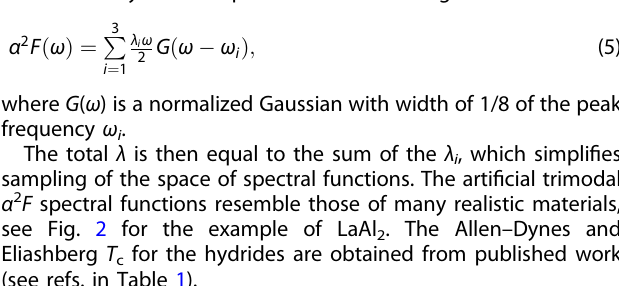
Figure 1 outlines our methods and computational work fl ow.